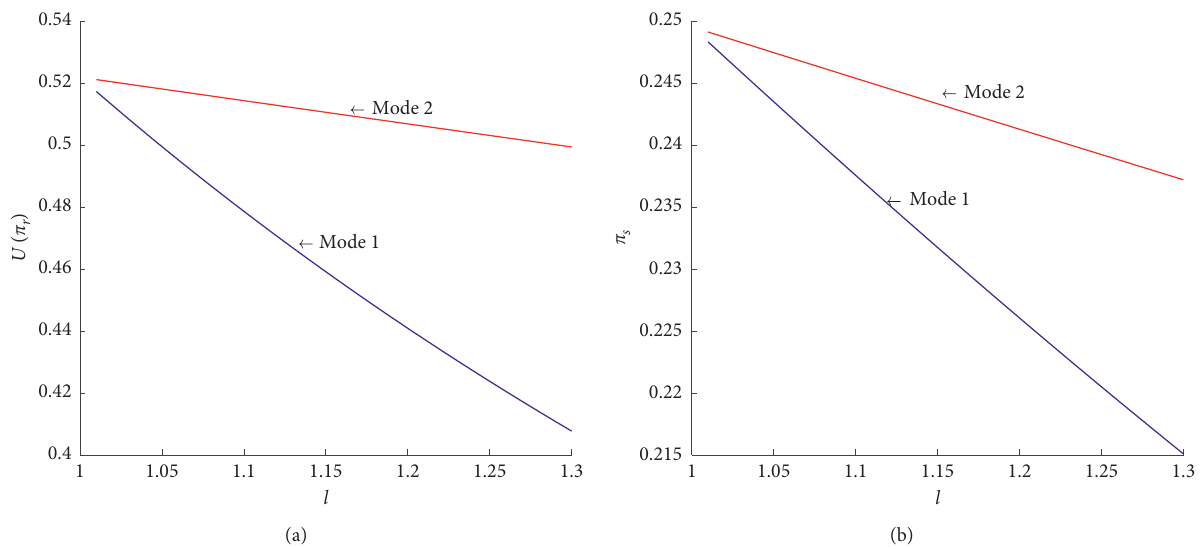
Figure 6: (a) The food processor’s utility as l changes. (b) The supplier’s profit as l